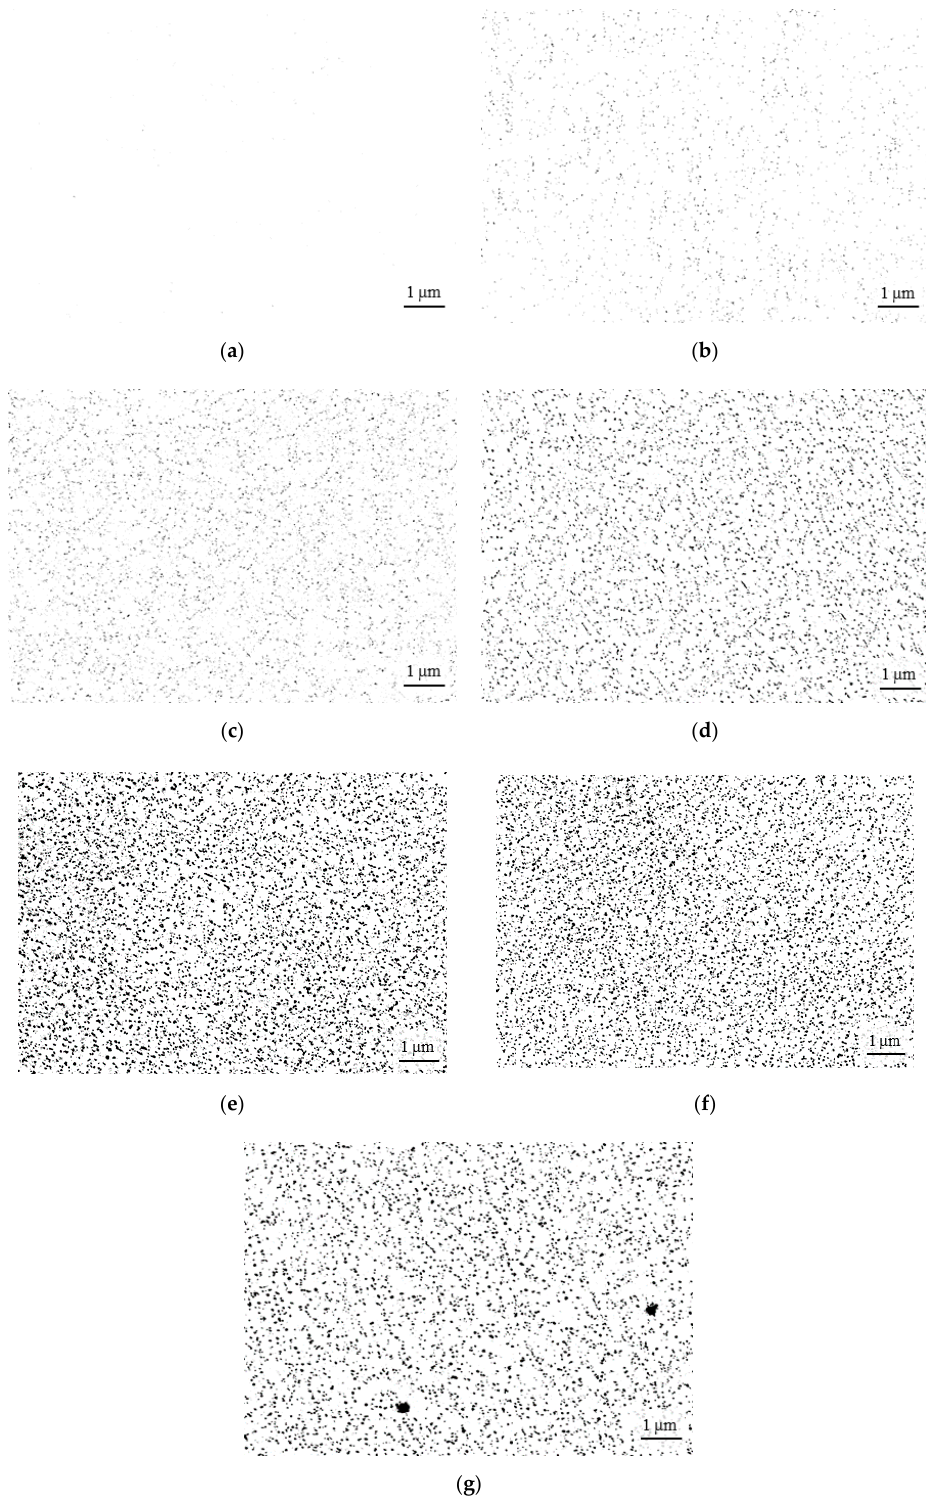
Figure 7. Scanning electron micrographs (post-processed, binarized and inverted for better particle visibility) of intragranular Laves phase precipitate evolution in ferritic Crofer ® 22 H steel during TMF cycling: 10 ( a ), 20 ( b ), 35 ( c ), 250 ( d ), 2000 ( e ), 3000 ( f ) and after failure at 4342 cycles ( g